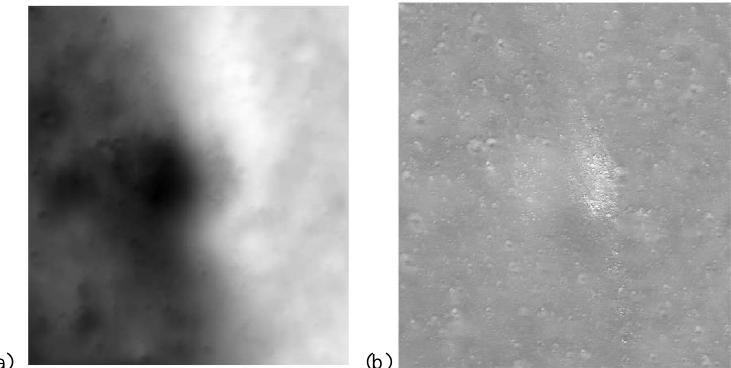
Figure 4. (a) The refined DEM obtained with our SAfS algorithm and (b) the refined albedo map of the region.